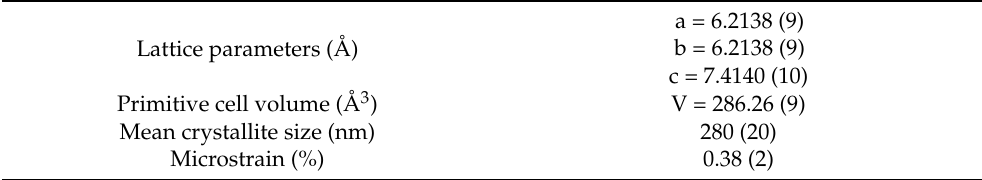
Figure 1. The polyhedral illustration of the structure of the VOPO 4 · 2H 2 O created by the molecular and crystal structure visualization software Diamond 3.2 ( left ); the positions of water molecules ( right ). Table 1. The main results of the refinement in the space group P4/ nmm